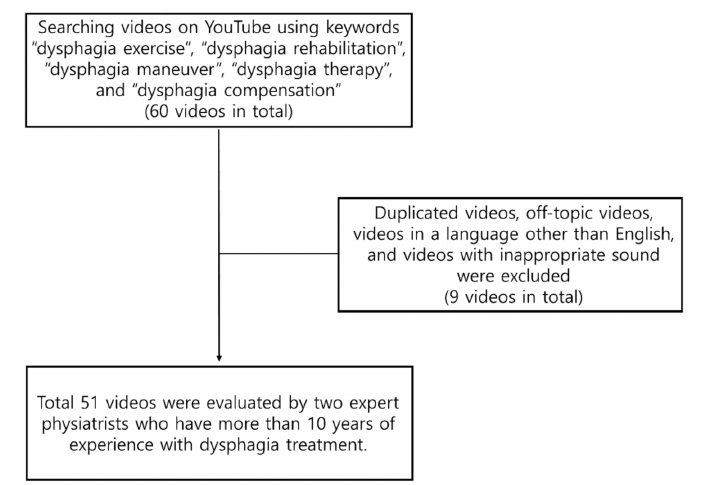
Figure 1. The flowchart of this